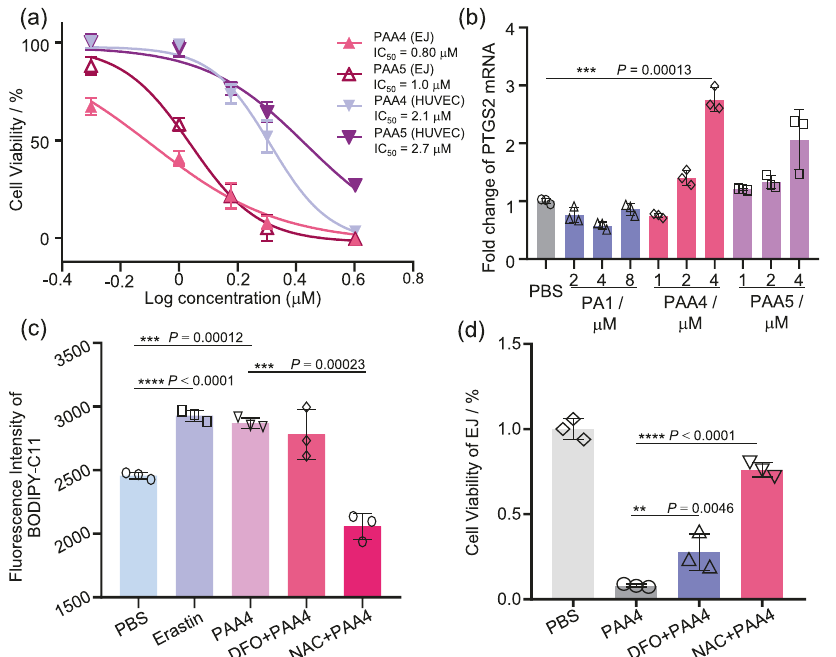
Fig. 4 | Invitro antitumor activityevaluation ofPAA4 and PAA5. a Cell viability assayof EJand HUVEC cells treated with PAA4 (IC500.8 μ M for EJ cells and 2.1 μ M forHUVECcells)and PAA5 (IC501.0 μ MforEJcellsand2.7 μ MforHUVECcells)for 24h. b ChangesofPTGS2mRNAinEJcellstreatedby PAA4 , PAA5 ,and PA1 for6h. c FluorescenceintensityoflipidperoxidationlabeledbyBODIPY-C11inEJcells.DFO (100 μ M) or NAC (3.0mM) was pretreated 2h before the PAA4 (4.0 μ M, 6h incu- bation) treatment. d Rescue effect of DFO (100 μ M) or NAC (3.0mM) on the